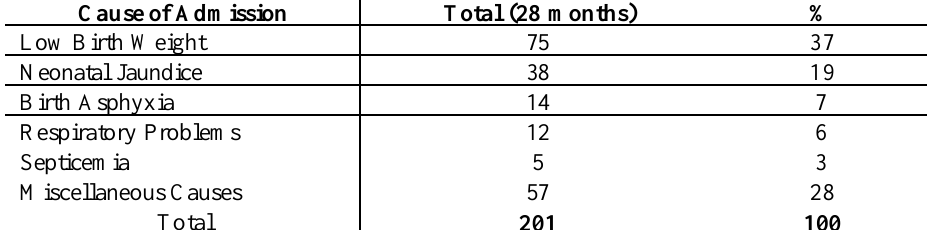
Table III : According to cause of admission of the babies admitted in the SCBU Cause of Admission